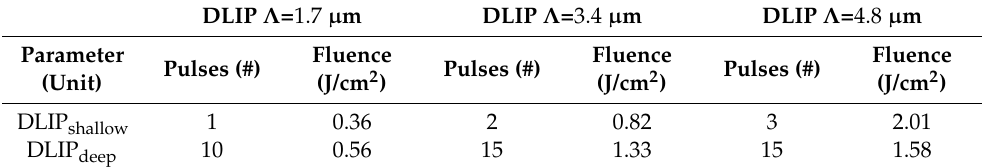
Table 1. Applied number of pulses and laser fluence for shallow and deep dot-like DLIP